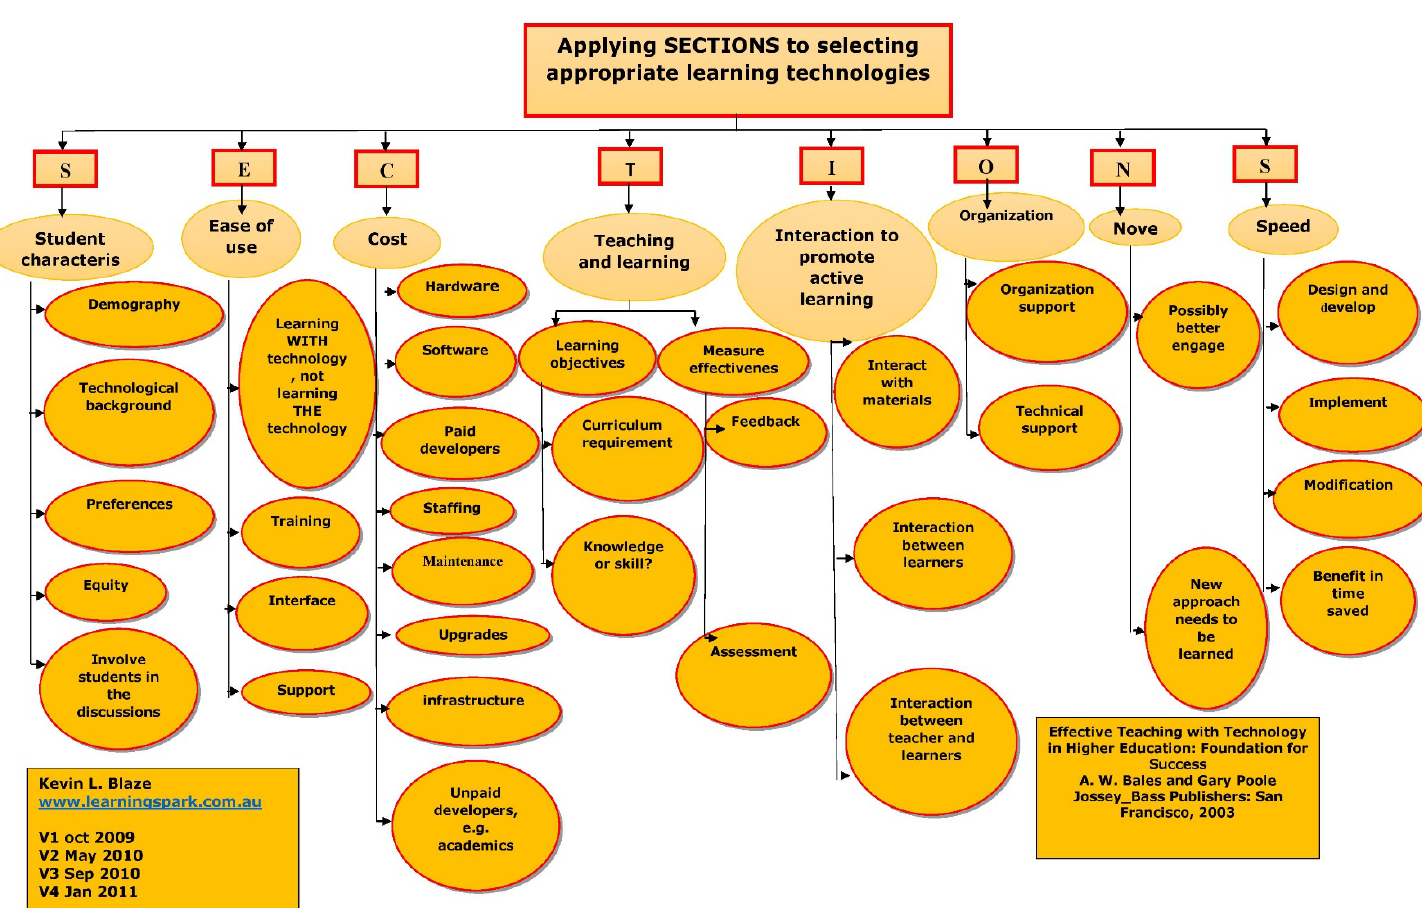
Bates and Poole’s (2003) SECTIONS